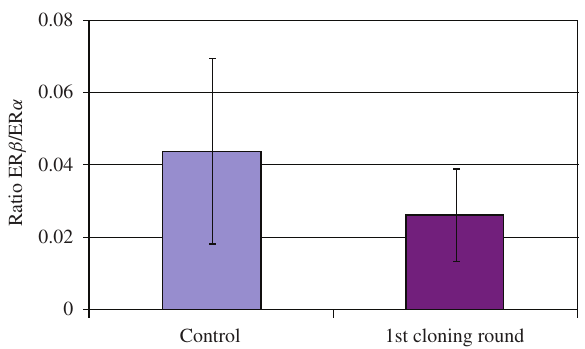
FIGURE 3: Ratio of ER β - to ER α -expression in endometrial stroma cell cultures after the first cloning round. Error bars = SEM, n = 11 , P = n . s